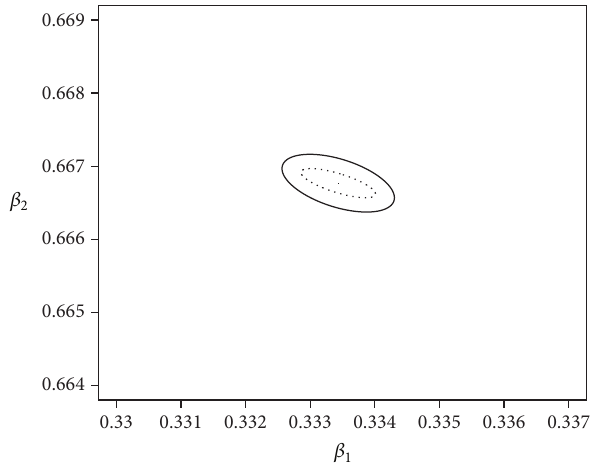
Figure 1: Averages of 95% confidence regions of ( 𝛽 1 , 𝛽 2 ), based on EEL (solid curve) and AEL (dashed curve ) when 𝑛 = 100 in the cases of Example